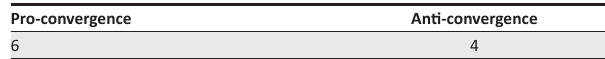
TABLE 3: Sentiment regarding